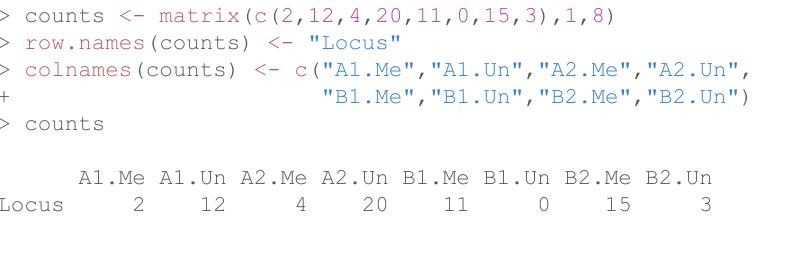
Table 2. A slightly less small example data set with n = 2 replicates for each